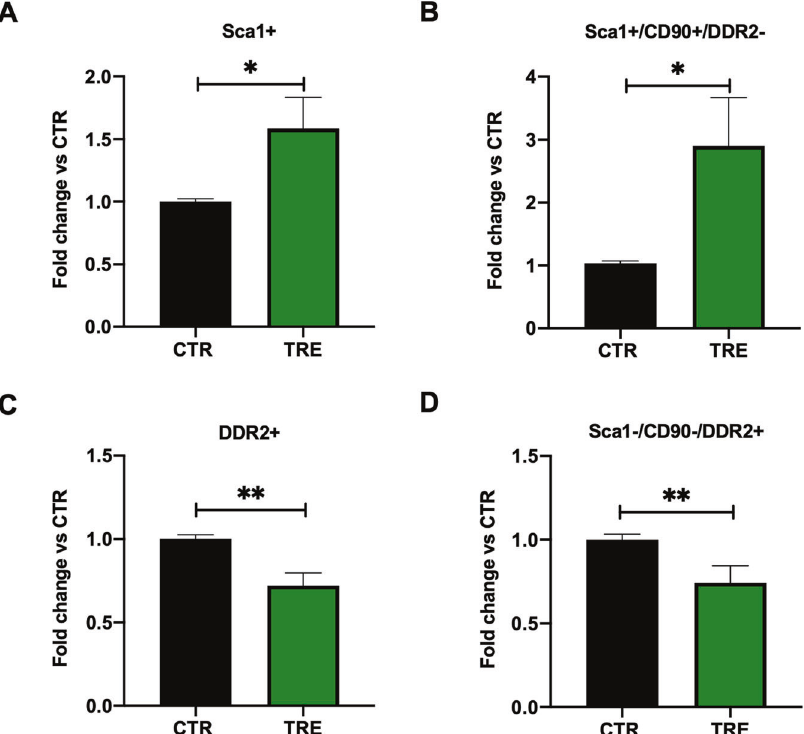
Fig. 4 Autophagy stimulation enriches CSCs with primitive mesenchymal cells. Normalized quanti fi cation by fl ow cytometry of the CD45-/ Flk1-/Sca1 + population (A) , the Sca1 + /CD90 + /DDR2- mesenchymal primitive subpopulation (B) , the whole CD45-/Flk1-/DDR2 + fi broblast- like fraction (C) , and of the Sca1-/CD90-/DDR2 + subpopulation (D) in CSCs after 32 hours of nutrient deprivation stress, with or without pretreatment with 50 mM trehalose (TRE) for 24 hours ( n = 8). * P <0.05, ** P